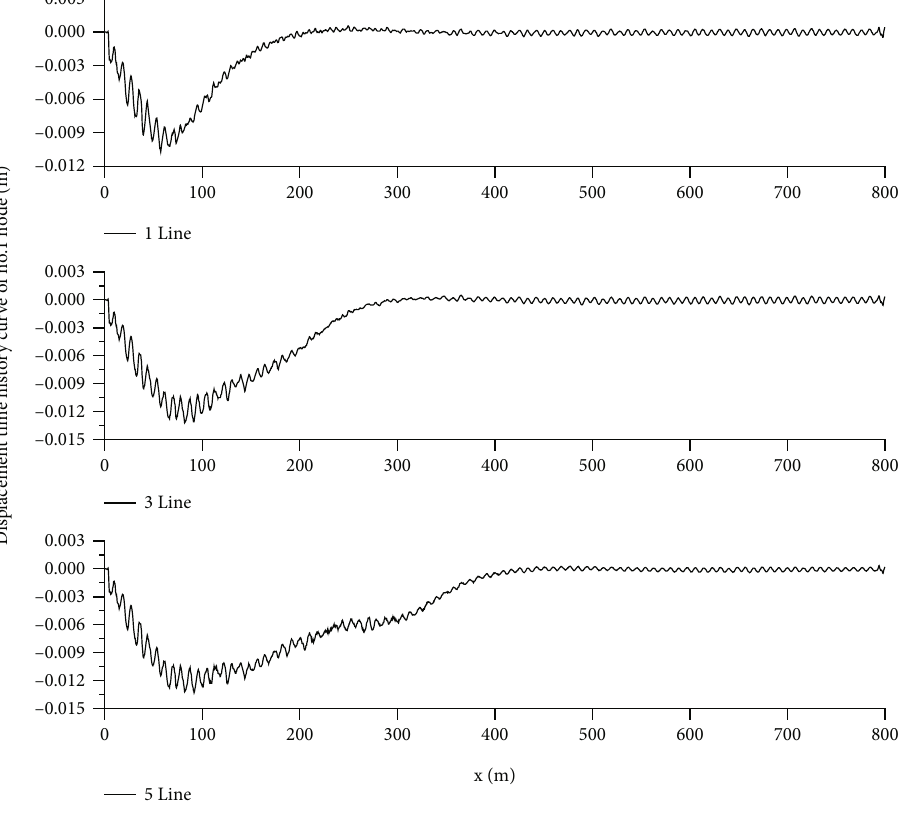
Figure 8: Displacement time history curve of fi rst node.